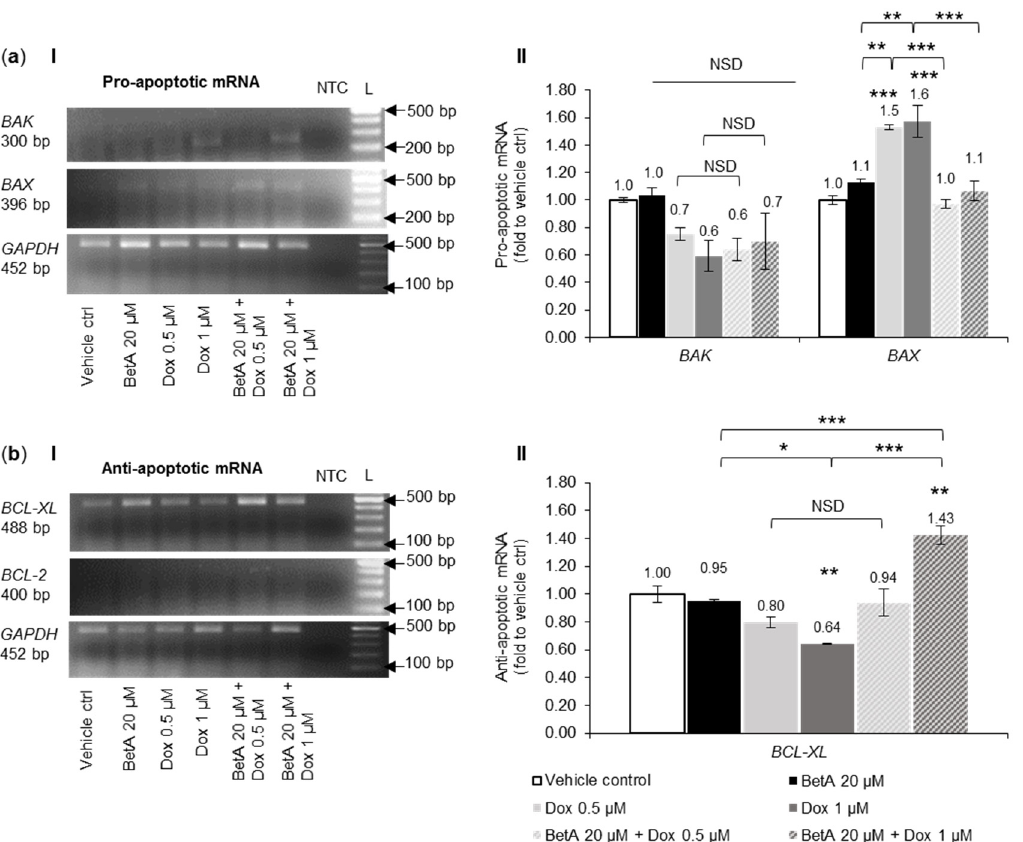
Figure 7. Expression of pro- and anti-apoptotic Bcl-2 family member genes in U-937 cells after co-treatment with single and combination drug for 48 h. Gene expression by gel electrophoresis ( I ) of U-937 treated cells quantified ( II ) using ImageJ software. The mRNA expression of pro-apoptotic ( a ) BAK and BAX ( n = 3) and anti-apoptotic ( b ) BCL-2 and BCL-XL ( n = 3) is relative to vehicle control (DMSO 0.05%, represented as 1.00-fold) and ratio between normalised data and GAPDH (housekeeping gene). NTC—non-template control. L—molecular ladder PCRBIO Ladder IV (100–1500 bp). Result were expressed as mean +SE. The data set was analysed by one-way ANOVA; Tukey post-hoc test. Statistical difference was accepted as following: p > 0.05 no significant difference (NSD), * p ≤ 0.05 significant, ** p ≤ 0.01 highly significant, *** p ≤ 0.001 very highly significant.